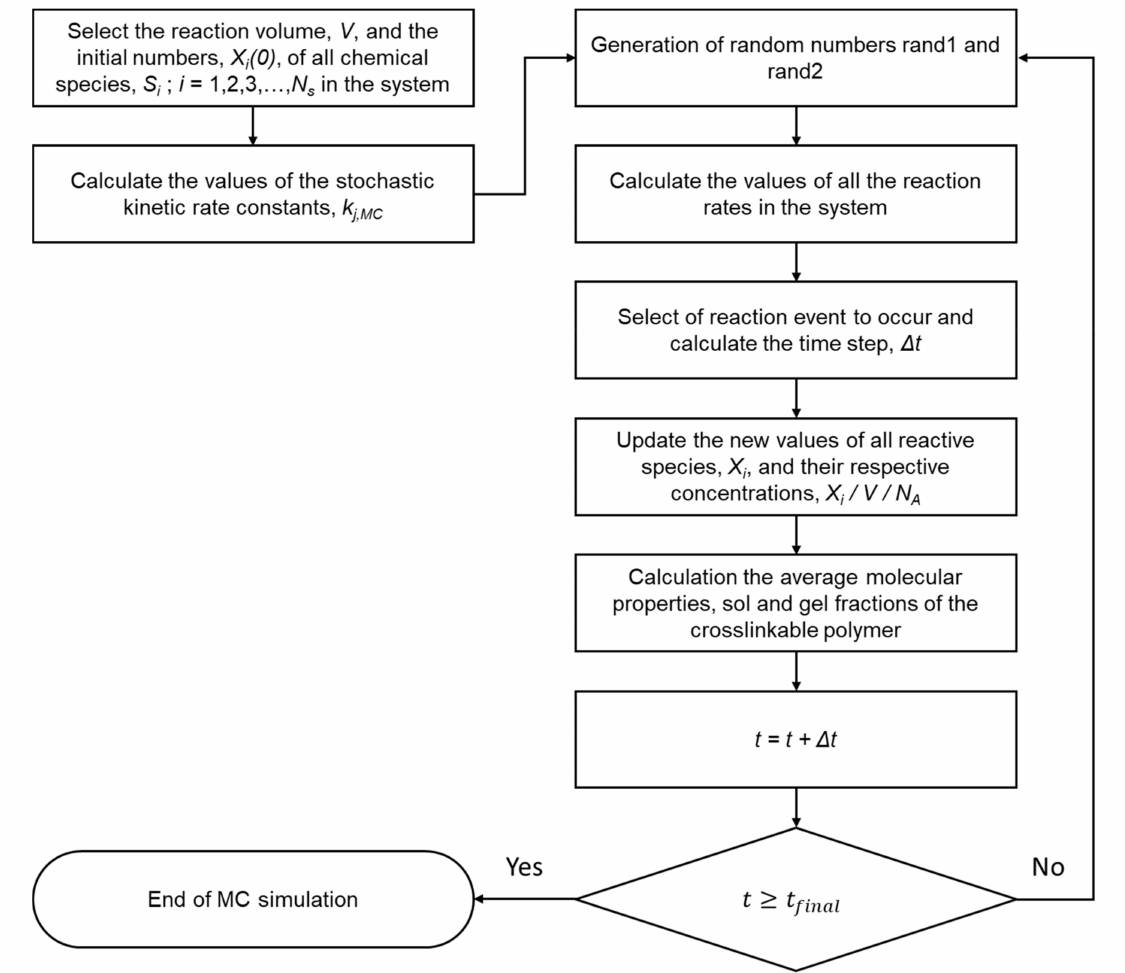
Figure 2. Schematic representation of Gillespie’s direct method